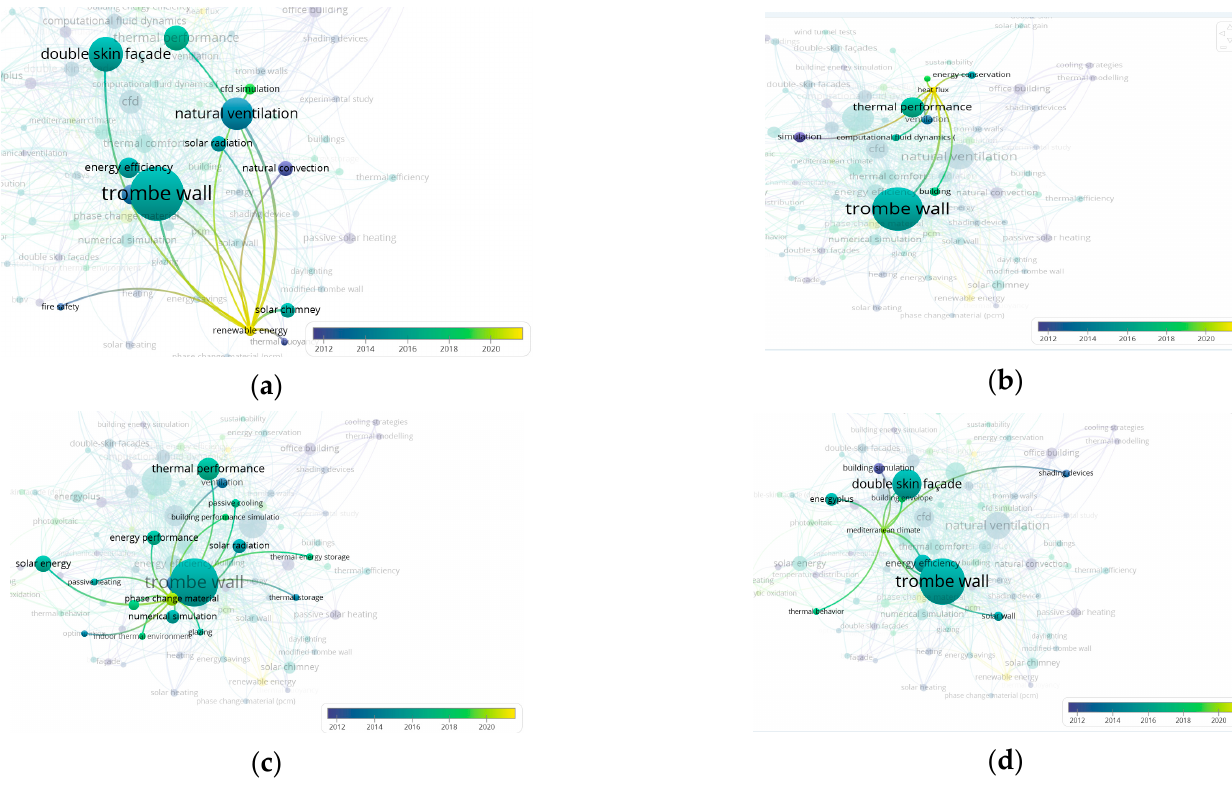
Figure 21. Modern keyword clusters for climate-adaptive façades ( a ) renewable energy, ( b ) heat flux, ( c ) phase-change material, ( d ) Mediterranean climate (accessed on 21 January